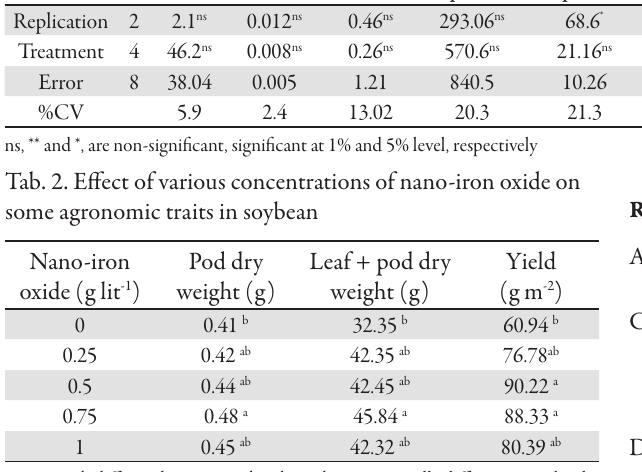
Tab. 1. Analysis of variance for traits in soybean Plant SOV df height